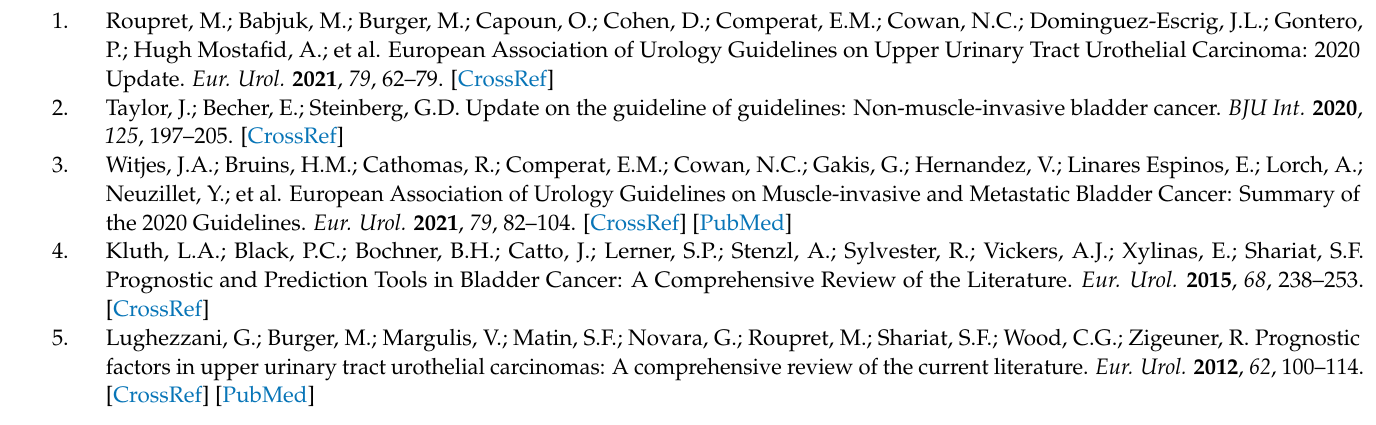
bladder cancer. Table S1: The detailed information of positively deregulated genes. Table S2: The detailed information of negatively deregulated